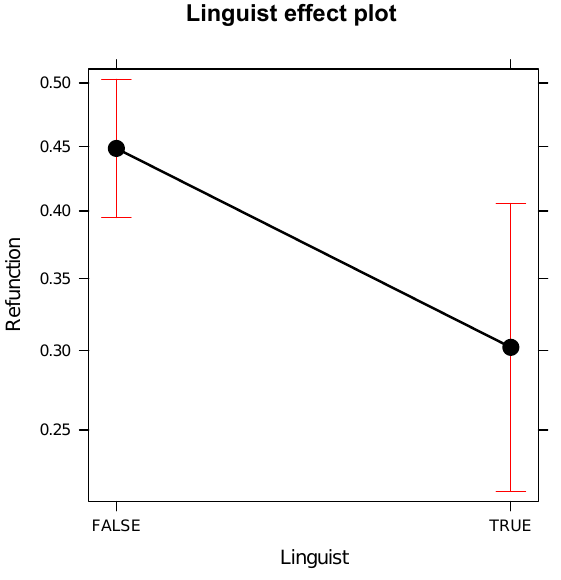
Figure 2. Effect plot for L INGUIST .